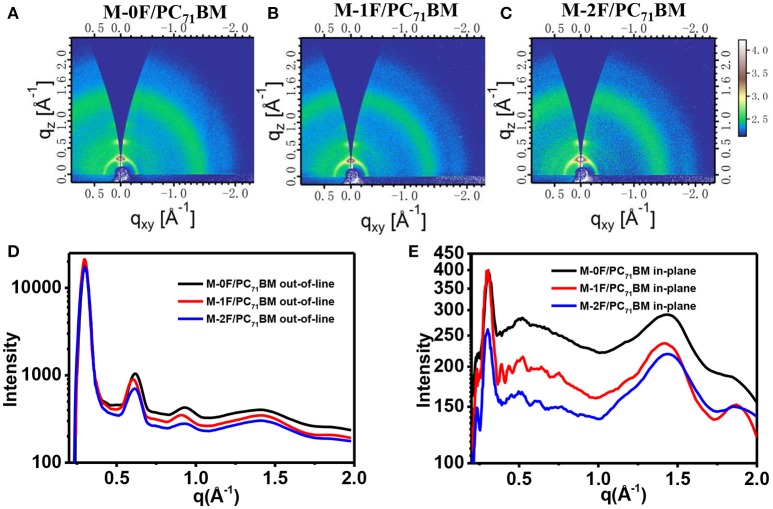
2D GIWAXS patterns of M-0F/PC71BM (A), M-1F/PC71BM (B), and M-2F/PC71BM (C) blend film. Out-of-plane (D) and in-plane (E) cuts of the corresponding 2D GIWAXS patterns.